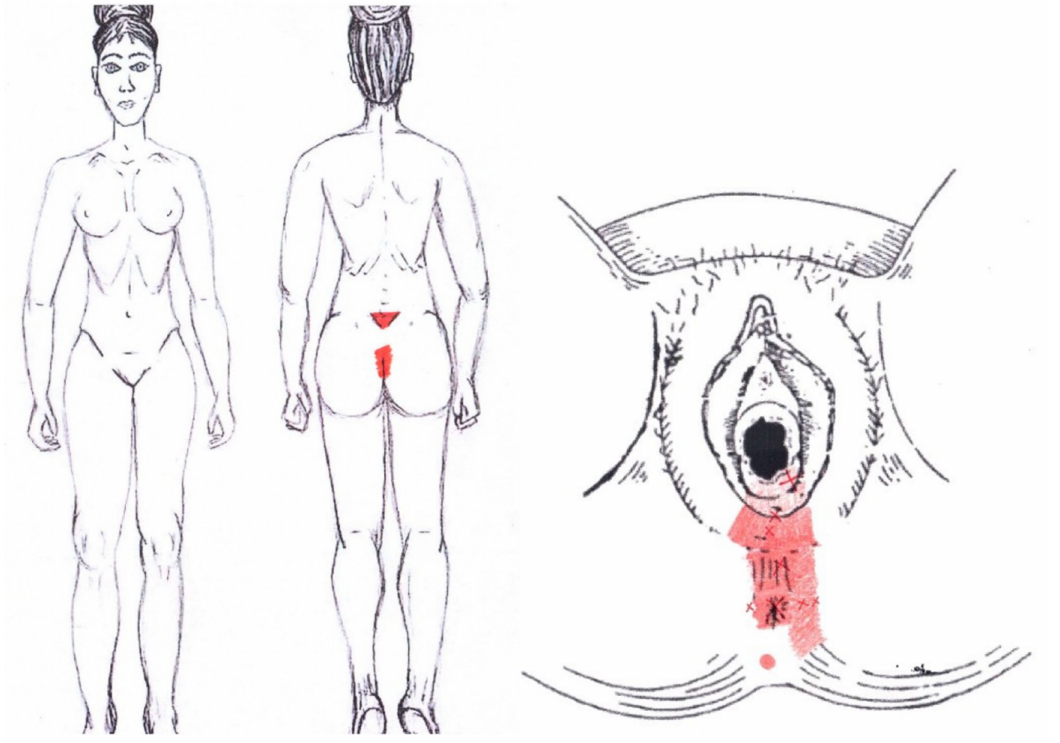
Figure 19. Graphical simulation of referred pain areas of the external anal sphincter